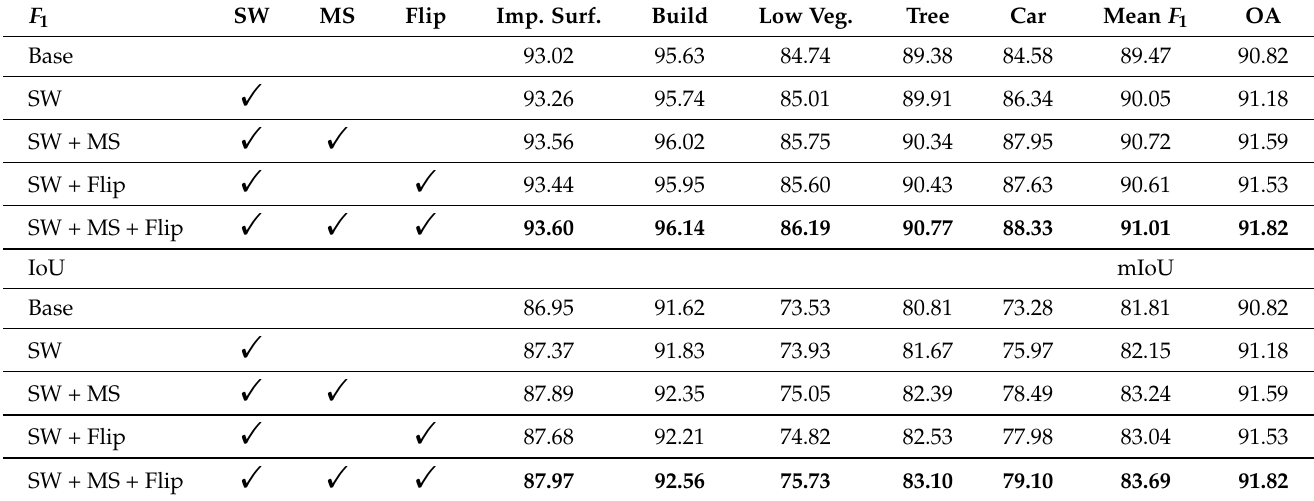
Table 10. Performance of different testing methods on the Vaihingen dataset.